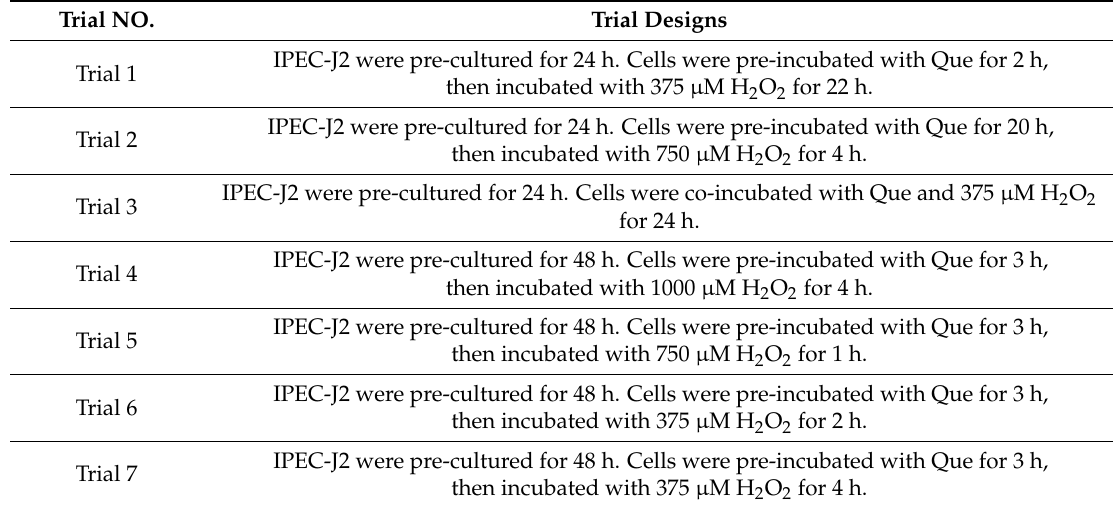
Table 1. Trial designs of the effects of Que on viability of IPEC-J2 treated with H 2 O 2 . Trial